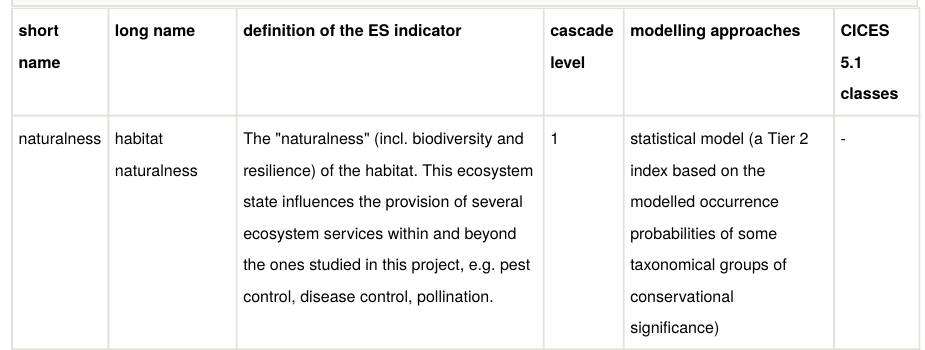
The list of ES indicators and ecosystem condition indicators selected for mapping in the Niraj- MAES project. Modelling approaches show the directions planned for model development at the stage of the ES selection, fi nal models & indicators are speci fi ed in Table 6. CICES classes noti fi cations follow Haines-Young and Potschin